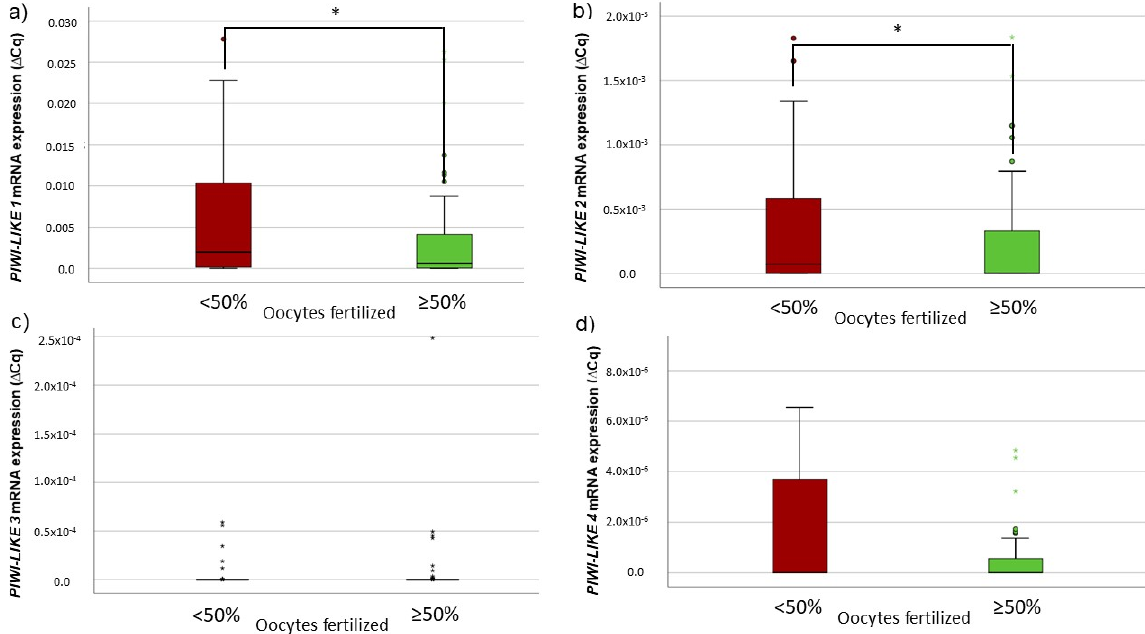
Figure 1. Association between fertilization success and ( a ) PIWI-LIKE 1 , ( b ) PIWI-LIKE 2 , ( c ) PIWI-LIKE 3 , or ( d ) PIWI-LIKE 4 spermatozoal mRNA levels in 160 ART cycles. * p < 0.05.